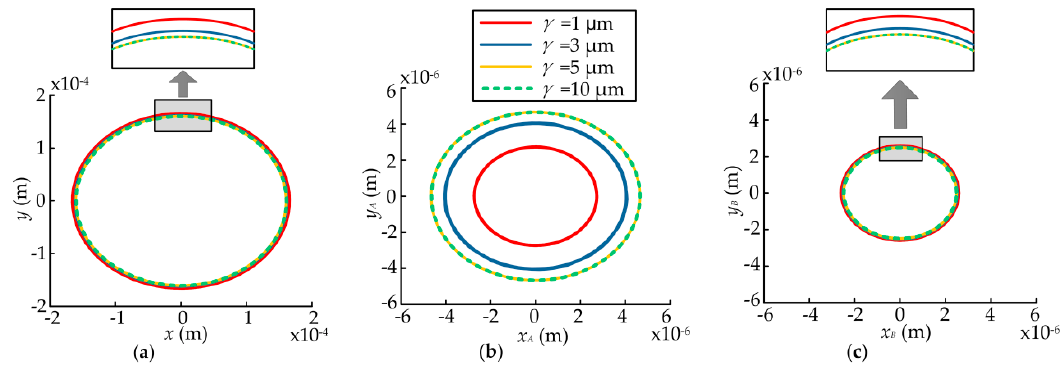
Figure 12. Rotor shaft orbits and bearing shaft orbits for different radial clearances. ( a ) Rotor shaft orbits; ( b ) Left-bearing shaft orbits; ( c ) Right-bearing shaft orbits.